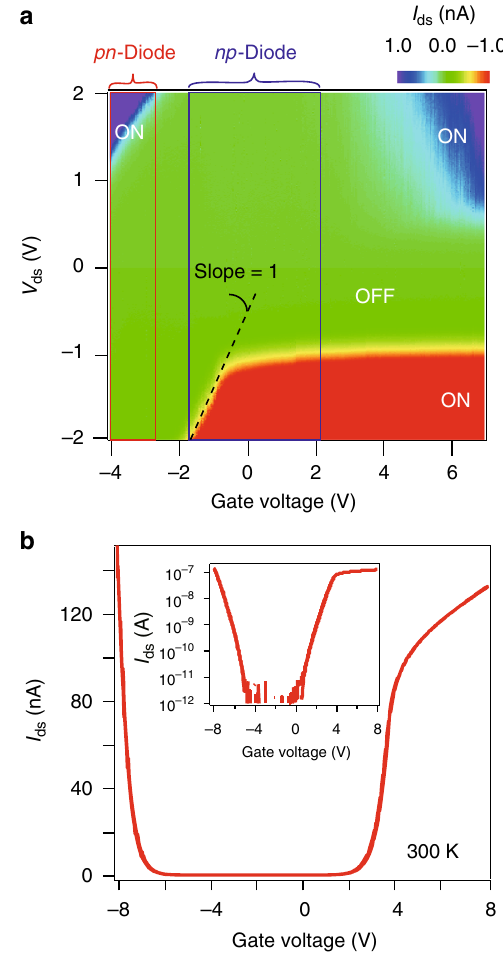
Fig. 2 Transport characteristics of MoS 2 TC-FETs. a Color map of output curves ( I ds vs V ds ) at different gate voltages for a typical tunnel-contacted device (room temperature operation). Red and blue-boxed areas highlight the operation range in gate voltage for pn and np diodes, respectively. b Typical ambipolar fi eld effect curve at V ds = +2 V measured in samples fabricated by the reverted vdW stacking method. Inset: same data in a semilog